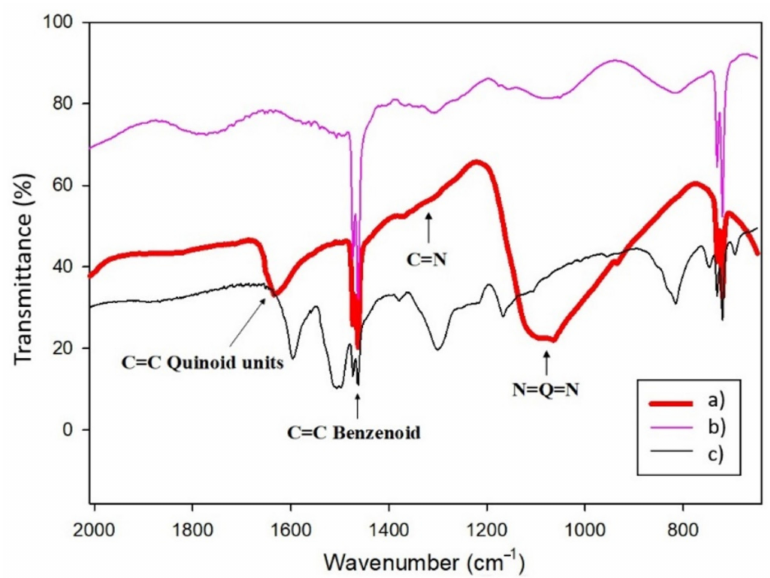
Figure 3. Infrared spectra of PANI-AuNPs synthesized using (a) 0.05 M LiClO 4 as dopant and (b) without dopant, compared with (c) commercial polyaniline. Q = quinoid